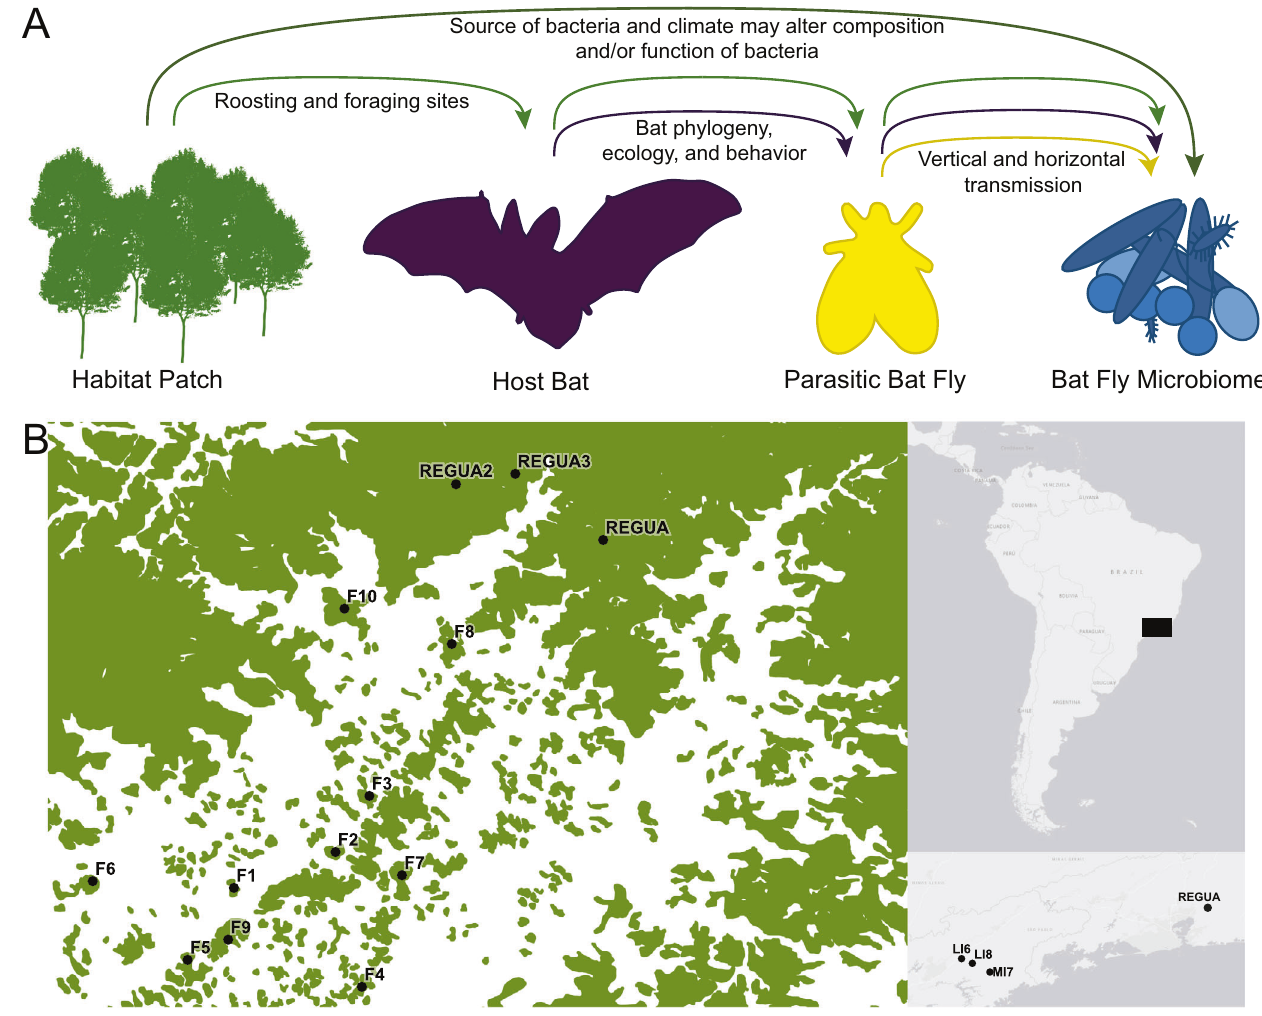
Fig. 1 Sampling design. Illustration of how environment ( “ habitat patch ” ), host bat, and parasitic bat fl y each in fl uence the microbiomes within bat fl ies ( A ; see in-text description for more details). Sampling map constructed in QGIS v3.12 of REGUA area sites with fragments outside of REGUA labelled with the pre fi x “ F ” and ordered from smallest (F1) to largest (F10; B ), the extent of the sampled area is shaded in black in the map at the top right, and the southern sites are mapped in relation to REGUA in the map on the bottom right. Green area of the map on the left indicates forested habitat based on imagery from SOS Mata Atlántica, while white areas are all non-forested habitat